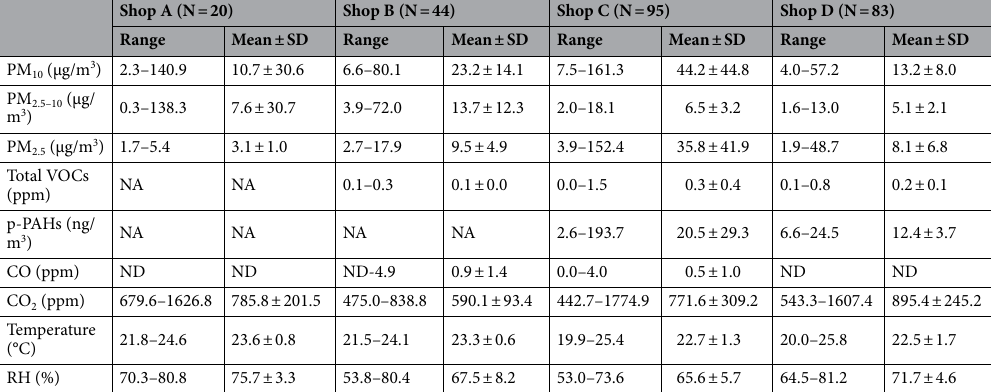
Table 1. Descriptive statistics of the concentrations a of indoor air pollutants and meteorological data a in the studied coffee shops. PM 10 , particulate matter with an aerodynamic diameter less than 10 μm; PM 2.5–10 , particulate matter with an aerodynamic diameter between 2.5 and 10 μm; PM 2.5 , particulate matter with an aerodynamic diameter less than 2.5 μm; Total VOCs, total volatile organic compounds; p-PAHs, particulate polycyclic aromatic hydrocarbons; CO, carbon monoxide (ppm); CO 2 , carbon dioxide (ppm); RH, relative humidity (%); NA, not available due to instrumental malfunction; ND, not detected. a Concentrations were 15-min averages.